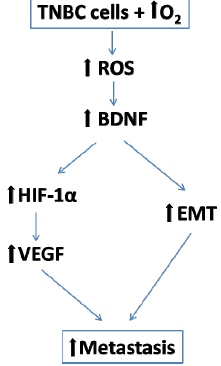
Figure 12. The potential role of BDNF in mediating cancer progression.